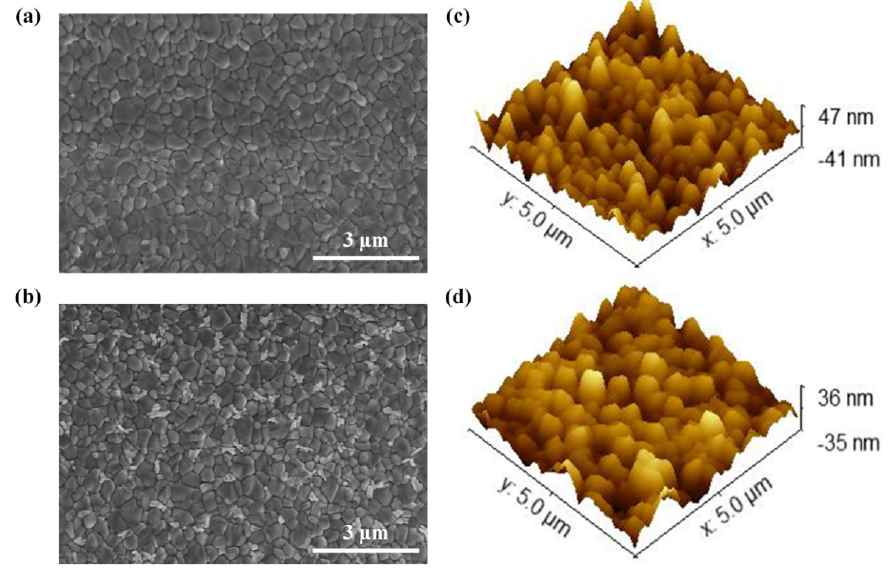
Figure 2. The top view SEM and AFM images of ( a,c ) pristine MA 0.7 FA 0.3 PbI 3 − x Cl x thin film and ( b,d ) MA 0.7 FA 0.3 PbI 3 − x Cl x thin film with PEOz treatment.